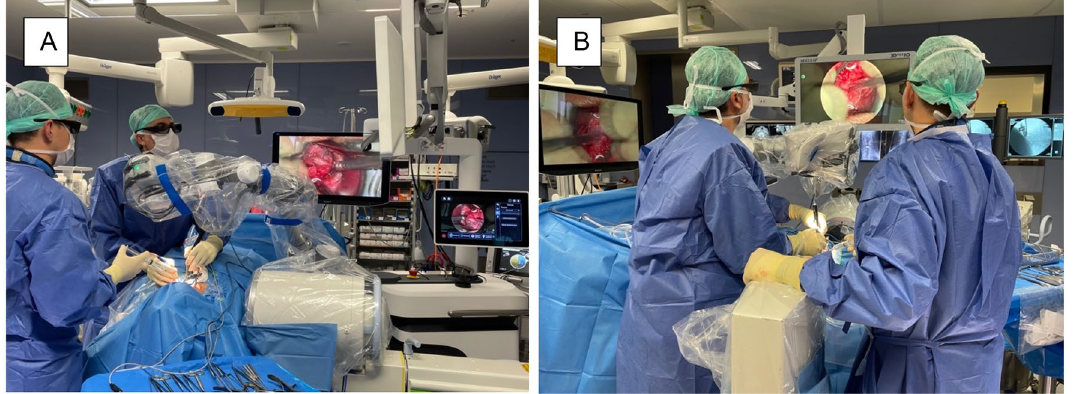
Figure 5. OR setup for ACDF: Surgical corridor remains unblocked with a good visualization for both surgeon and assistant. ( A ) Assistant‘s and OR nurse‘s 55 inch monitor is directly opposite of them; ( B ) 32 inch monitor is in front of the surgeon, fluoroscope is placed in lateral